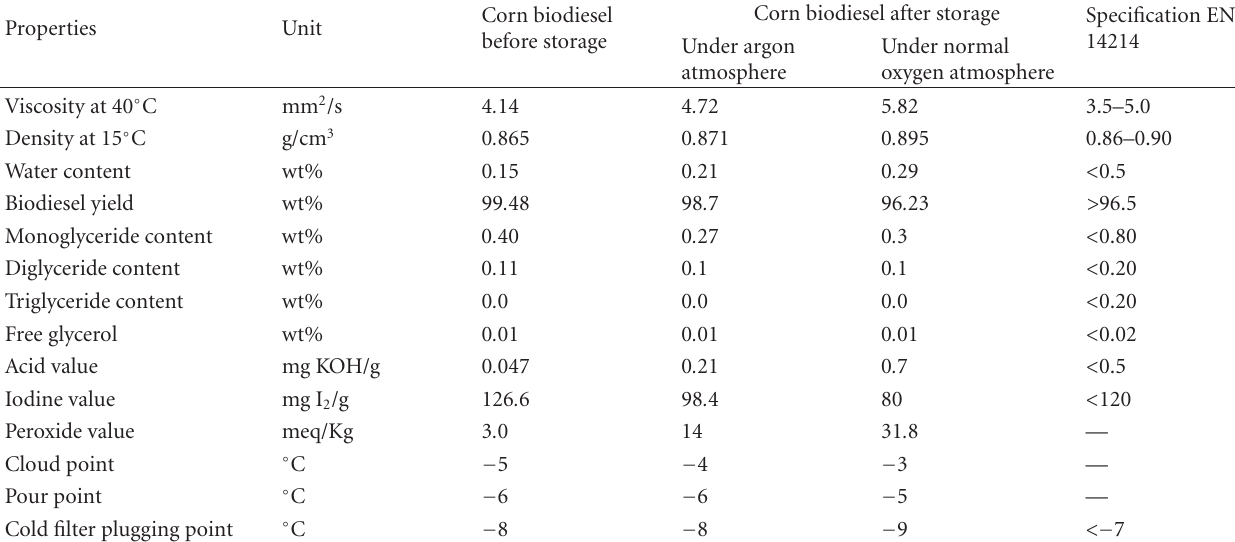
Table 4: Quality control of corn oil biodiesel fuels used in this study before and after storage time of 30 months compared to EN 14214 Properties